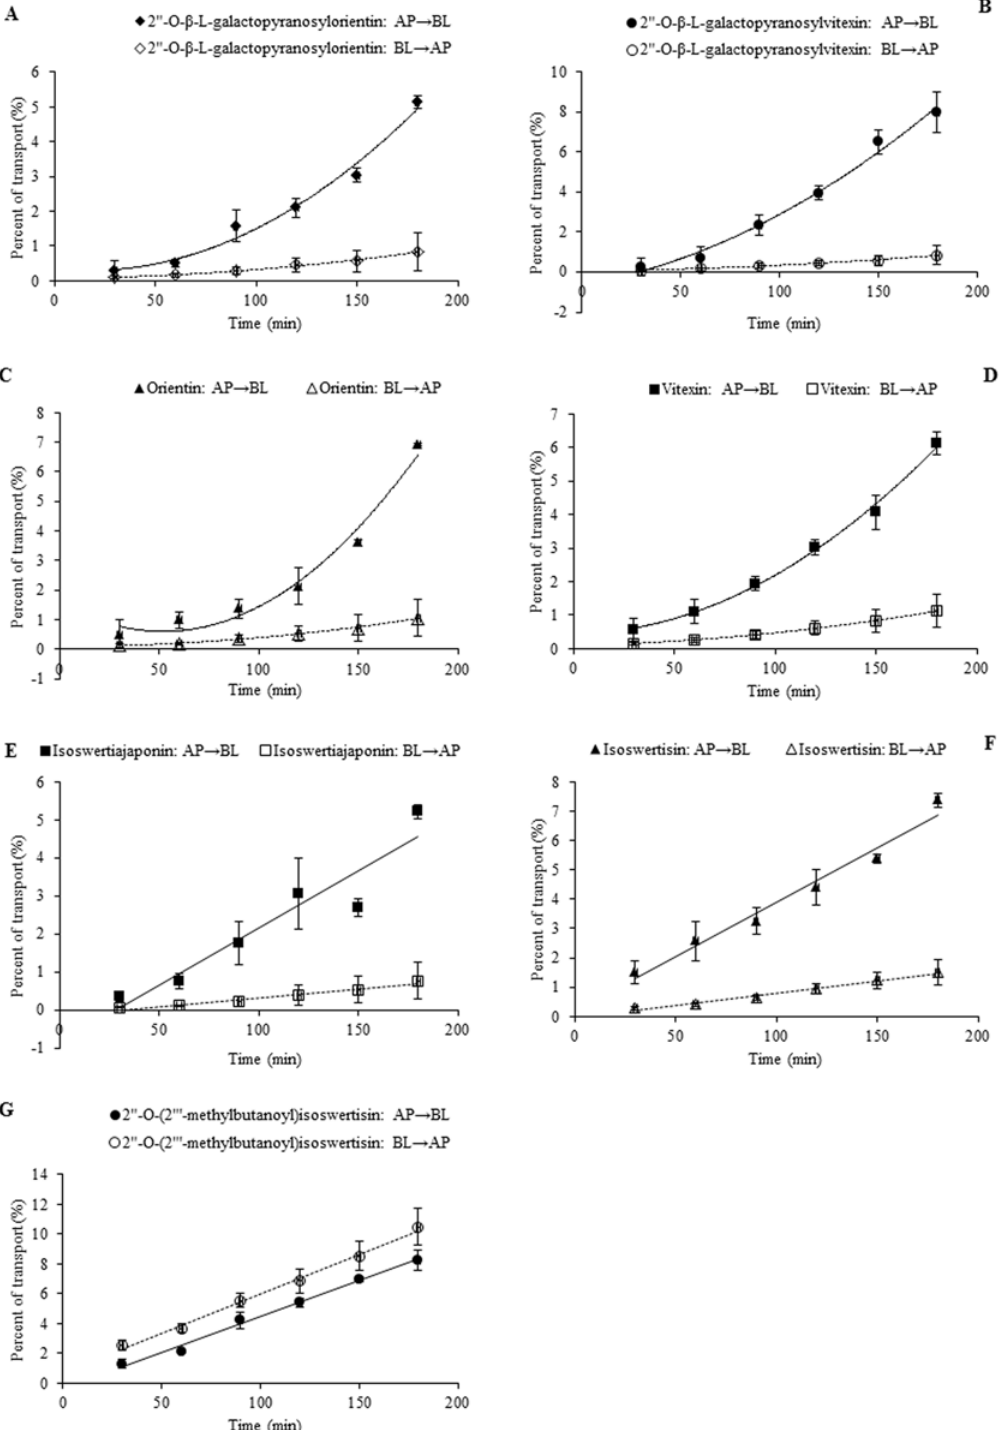
Fig 6. The percent transport of the seven flavonoids in the mixture as a function of time at 50 μ mol/L. Notes: (A) 2 ” - O - β -L-galactopyranosylorientin; (B) 2 ” - O - β -L-galactopyranosylvitexin; (C) Orientin; (D) Vitexin; (E) Isoswertiajaponin; (F) Isoswertisin; (G) 2 ” - O -(2 ”‘ -methylbutanoyl)isoswertisin.